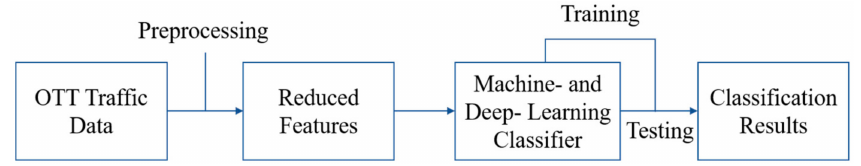
Figure 1. Machine- and deep-learning-based over-the-top (OTT) consumer classification